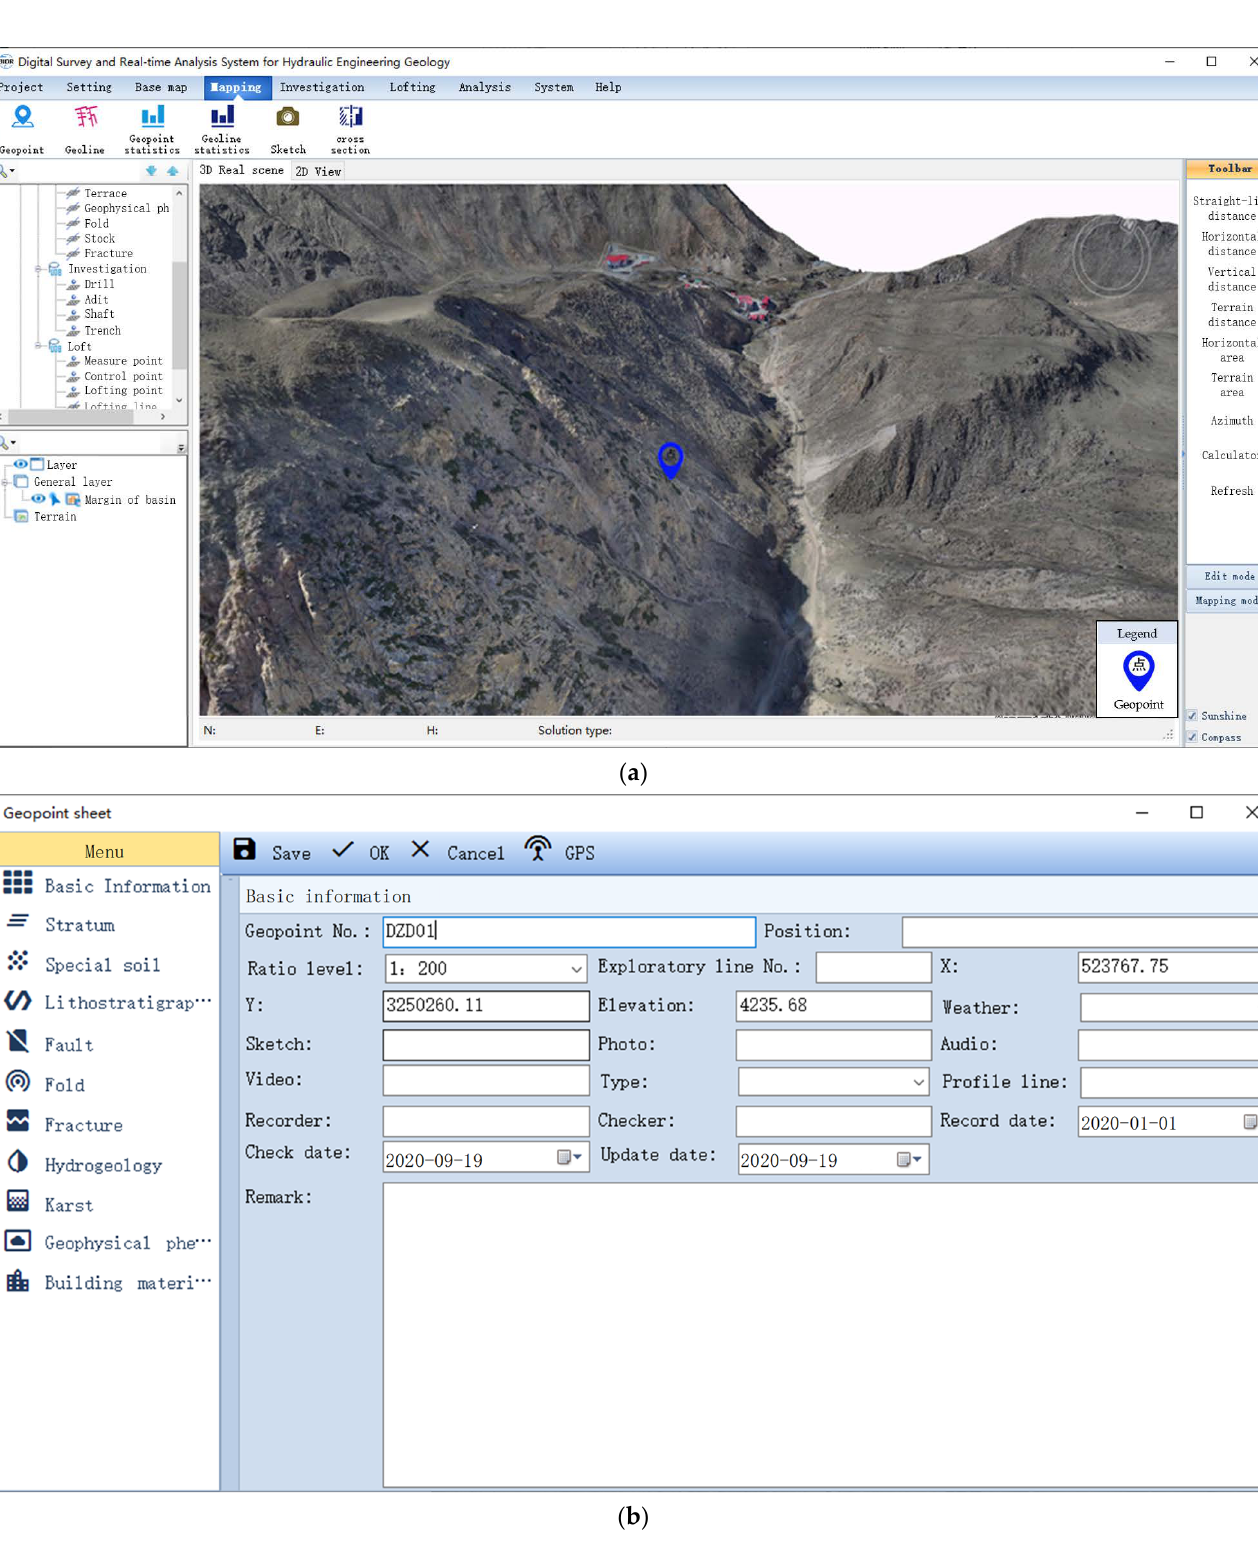
Figure 8. Geological data recording: ( a ) the recorded point on the map terrain; ( b ) the geological data recording card.